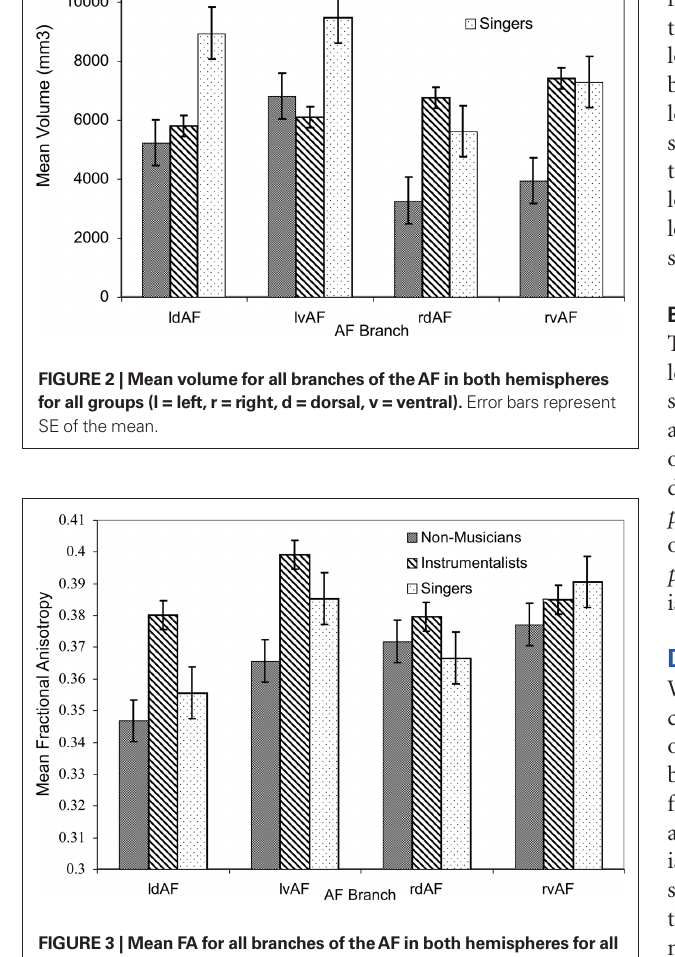
Figure 3 | Mean FA for all branches of the AF in both hemispheres for all groups (l = left, r = right, d = dorsal, v = ventral). Error bars represent SE of